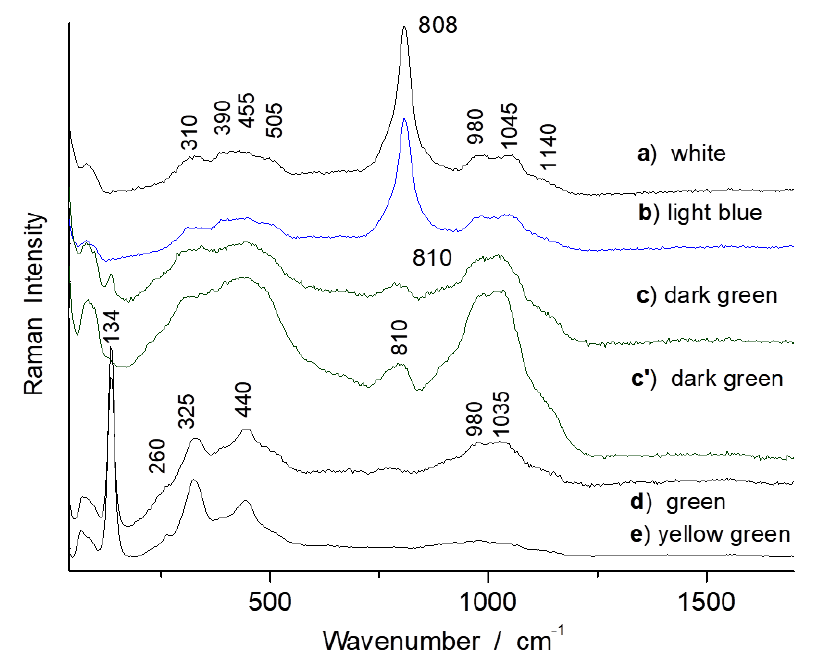
Figure 12. Representative Raman spectra recorded on the F1429C teapot porcelain (Qianlong period) for white (left, A , a), blue (left, A , b), dark green (right B , a and a′), yellow (right, B , b to b′′), pink (left, C , a and a′), red (left, C , b and b′), brown (right, D , a and a′) and black (right, D , b and b′) enamelled areas.